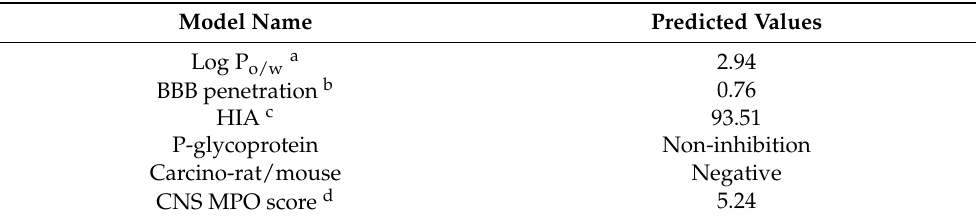
Table 4. Pharmacokinetic properties of